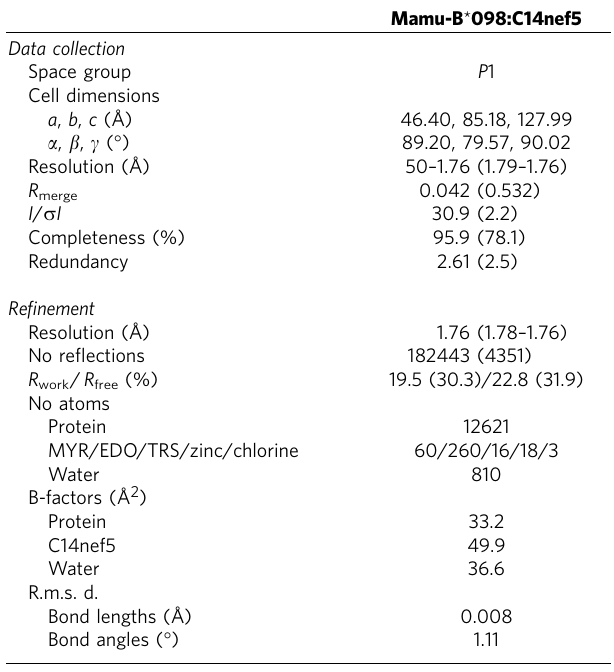
Table 1 | Data collection and refinement statistics (molecular